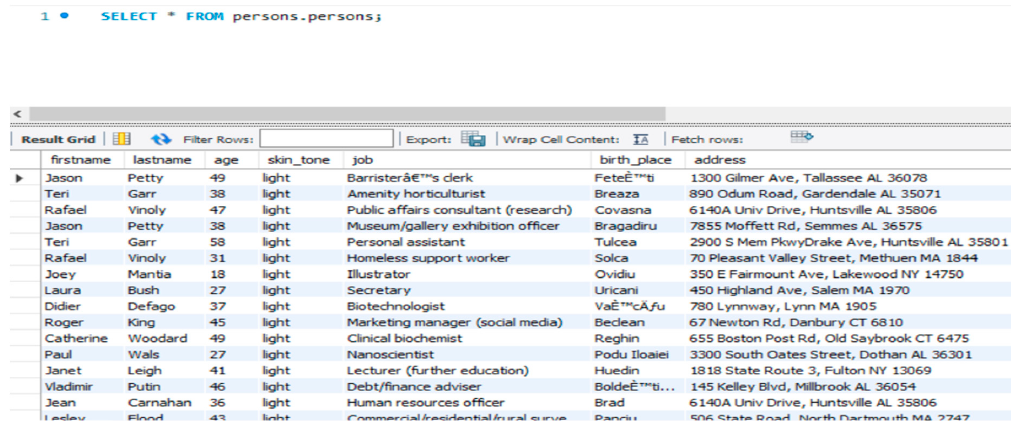
Figure 6. MySQL Workbench Database.